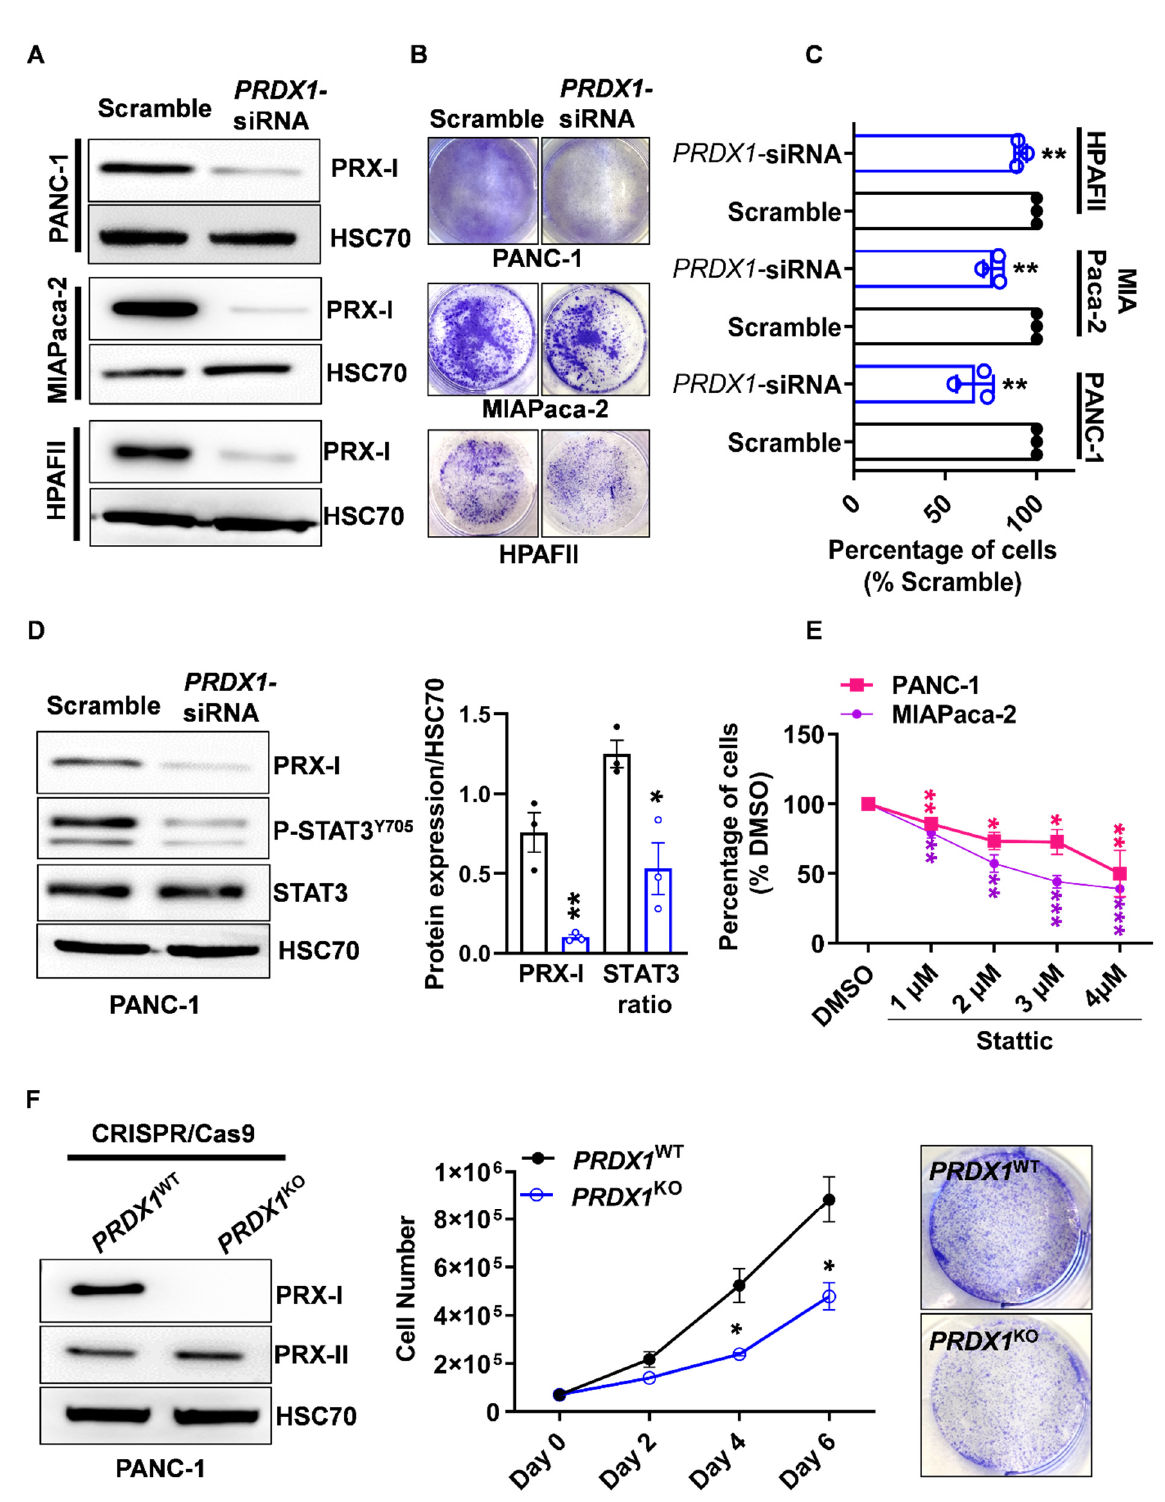
Figure 2. Peroxiredoxin-I (PRX-I) ablation reduces the growth of human pancreatic ductal adenocarcinoma (PDAC) cells. ( A ) Representative Western blot results for PRX-I on multiple human PDAC cell lines transfected for six days with scram- ble or specific Peroxiredoxin-1 gene ( PRDX1 ) - siRNA. Heat-shock cognate 70 (HSC70) was used as a loading control. On each cell line, siRNA transfection was performed on three independent culture passages ( n = 3) ( B ) Representative crystal violet staining for PDAC cell lines after six days of transfection with scramble or specific PRDX1- siRNA. ( C ) Determination of cell percentages from experiments shown in panel B ( n = 3). The percentage in the scramble conditions was considered to be 100%. ( D ) Western blot on PANC-1 cells after transfection with scramble or specific PRDX1- siRNA; Western blots were performed on three independent culture passages ( n = 3). The corresponding densitometric quantification for blots